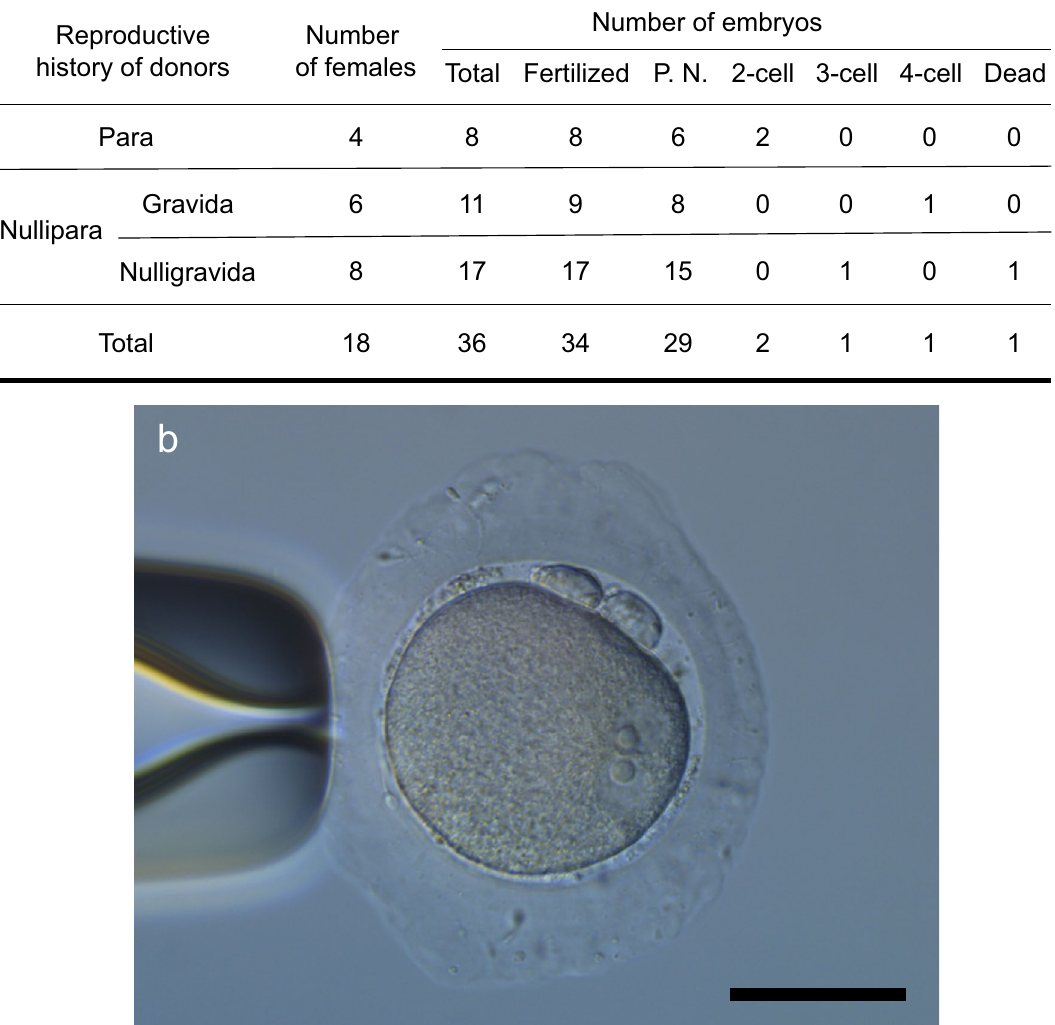
Figure 3. Embryos recovered from the oviduct of naturally mated females. ( a ) Thirty-six embryos were recovered from 18 naturally mated females. Twenty-nine (81%) of the embryos were at the pronuclear stage (P. N.). ( b ) A pronuclear stage embryo collected by flushing an oviduct of a naturally mated female. Two pronuclei are observed. A scale bar, 50